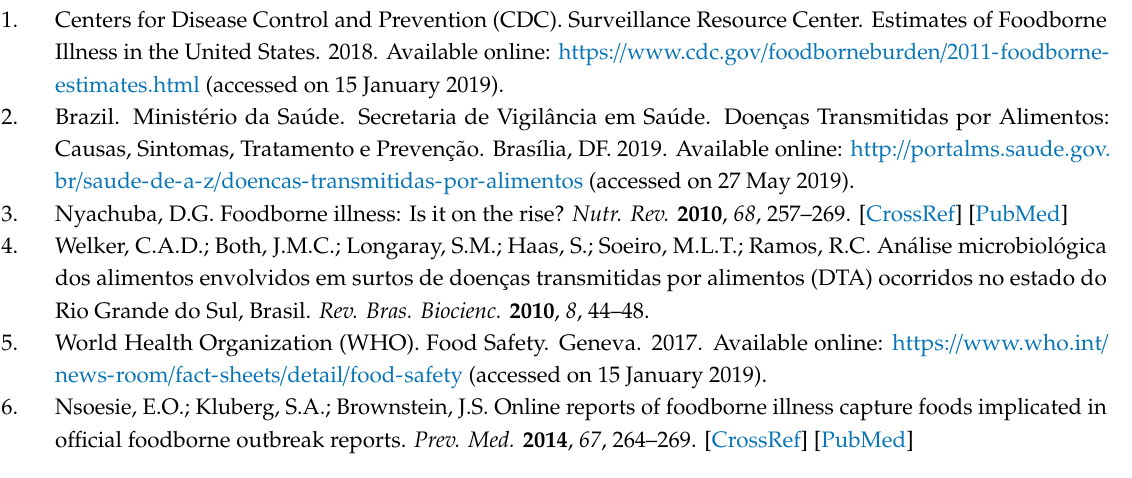
Table S1: Selected articles from the scientific literature; Table S2: Data obtained from the selected scientific